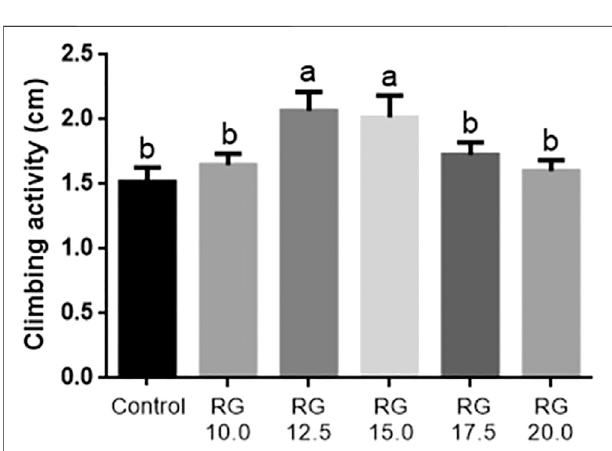
FIGURE 3 | Climbing ability test.The different lowercase letters mean signi fi cant difference at a 5% level with each treatment group.; Abbreviation: RG, red